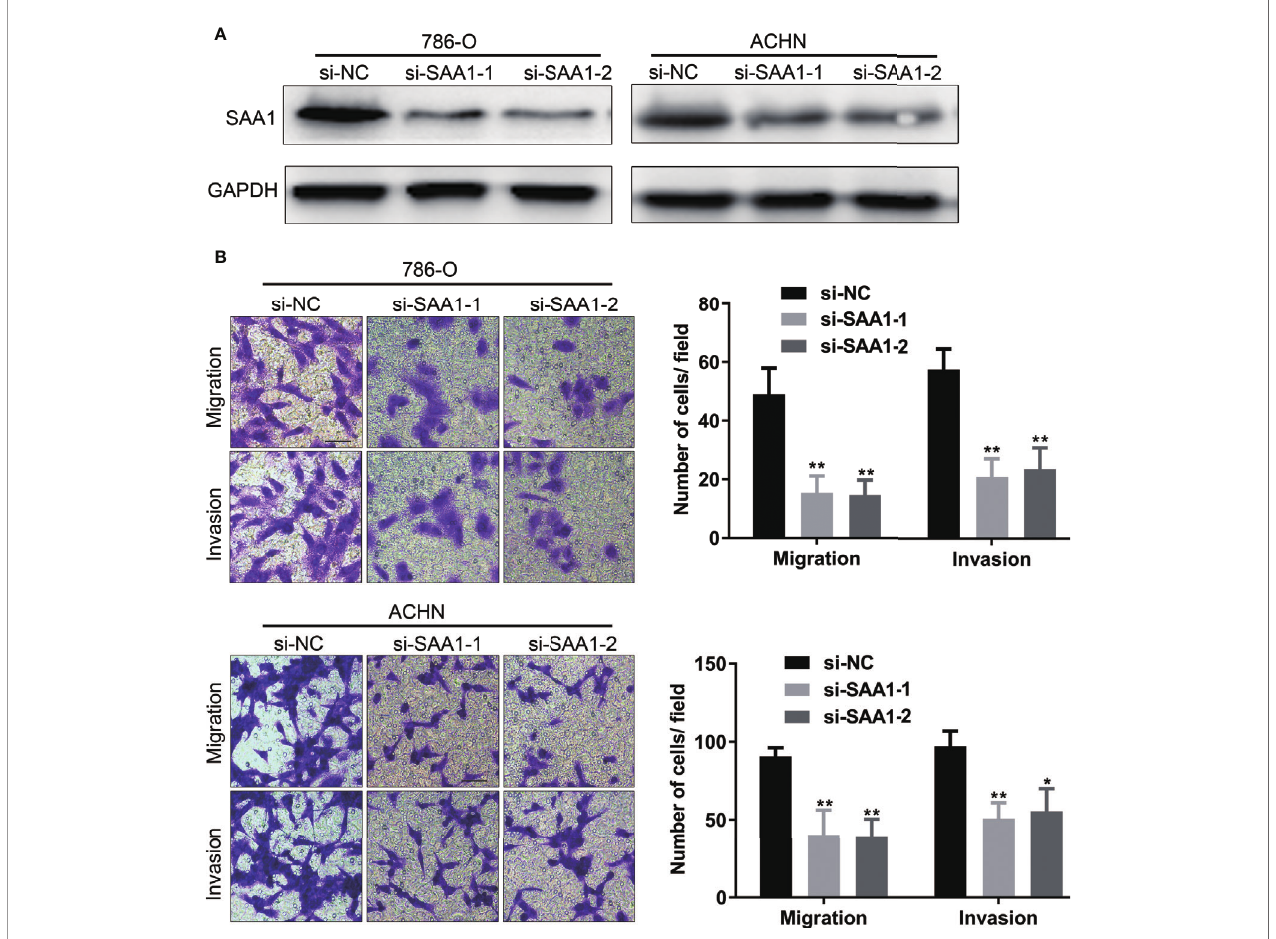
FIGURE 9 | SAA1 knockdown signi fi cantly inhibits migration and invasion of RCC cells in vitro . (A, B) Transwell assays analysis of the effect of SAA1 knockdown on cell migration and invasion of 786-O and ACHN. (**P<0.01, *P<0.05, compared with si-NC